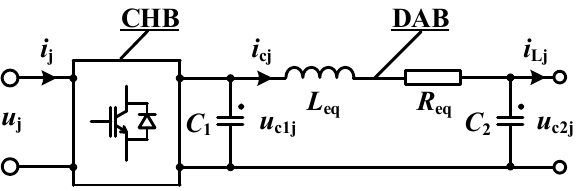
Figure 2. The equivalent circuit topology of DAB in the PET.